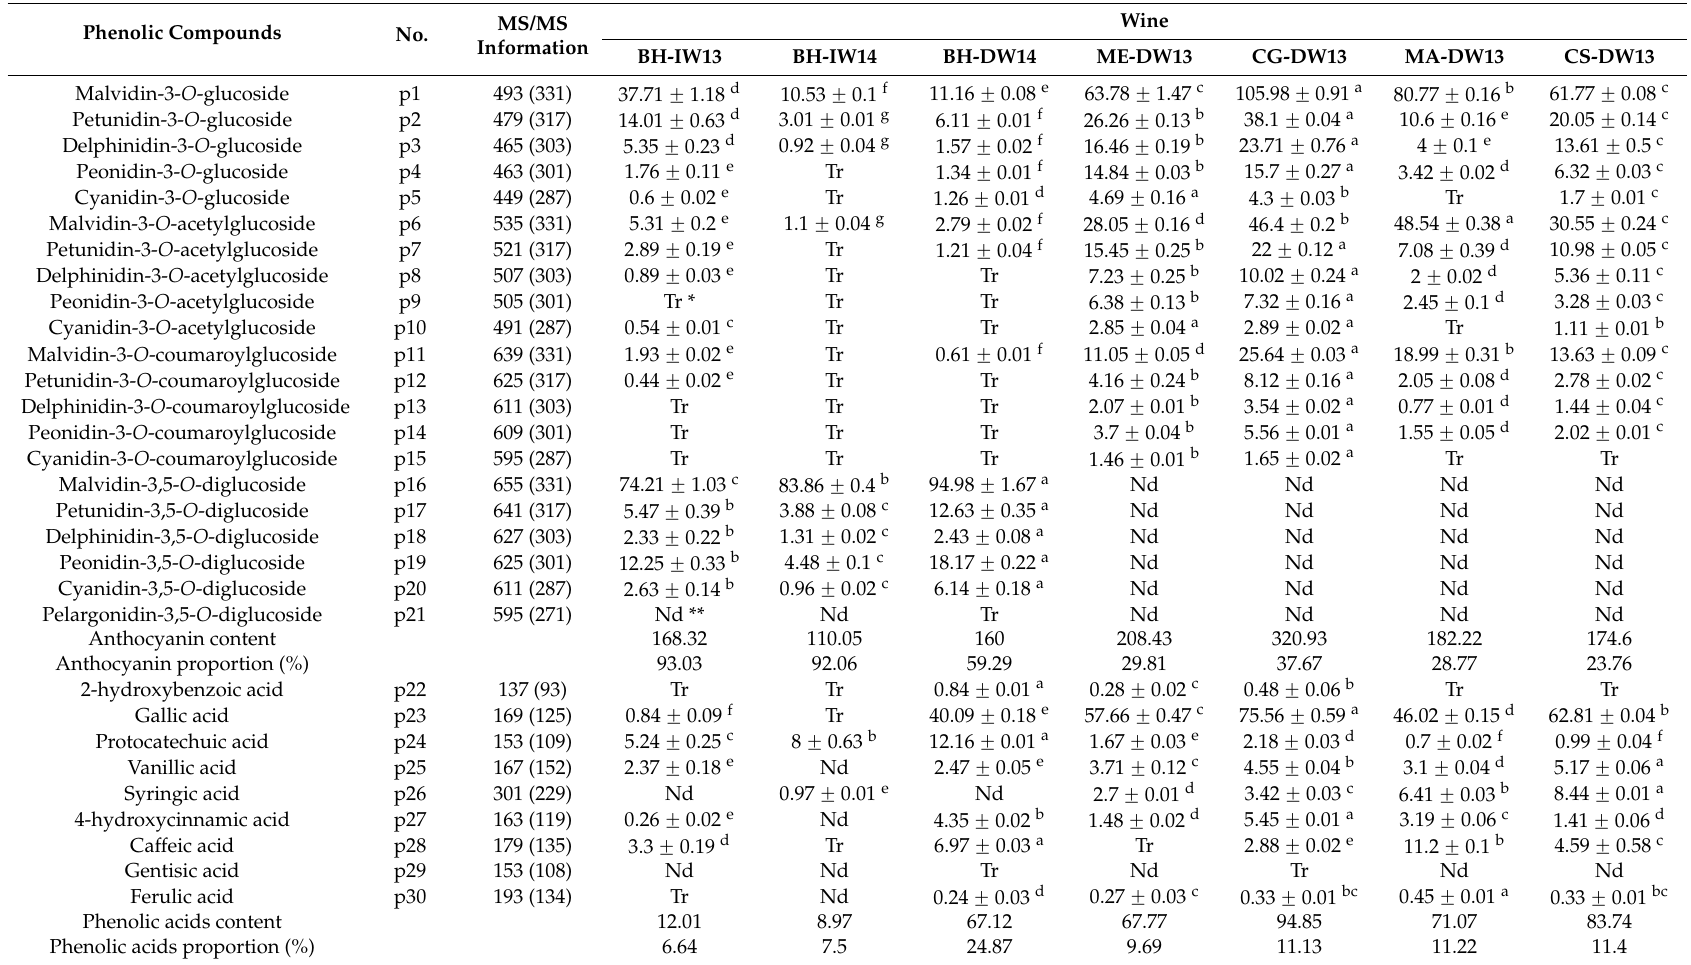
Table 3. The phenolic compound content (mg/L) of the seven trial